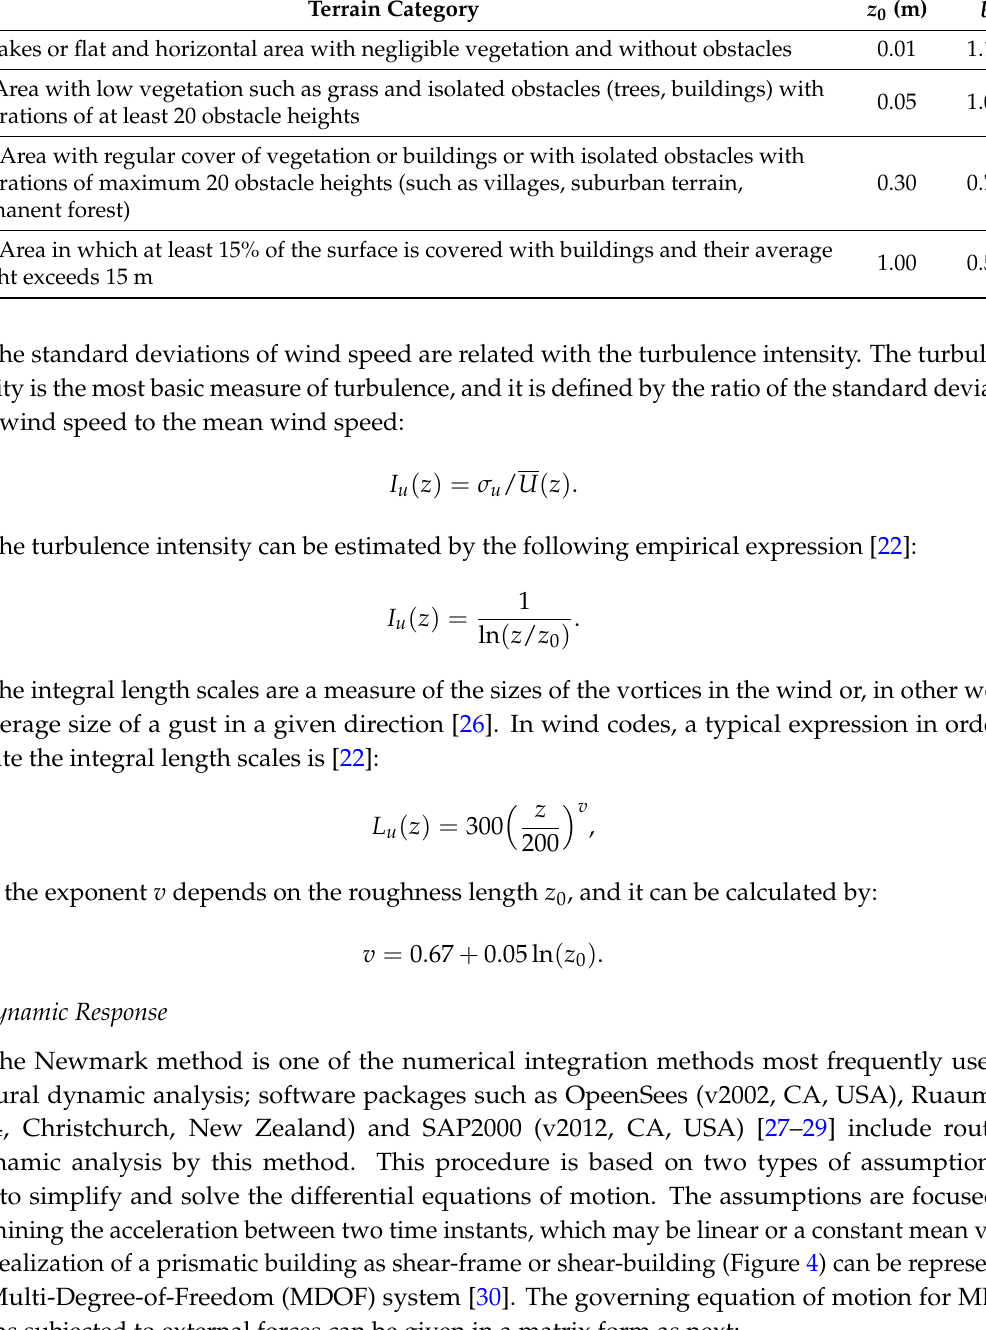
Table 1. Terrain categories and terrain parameters based in Eurocode [22]. Terrain